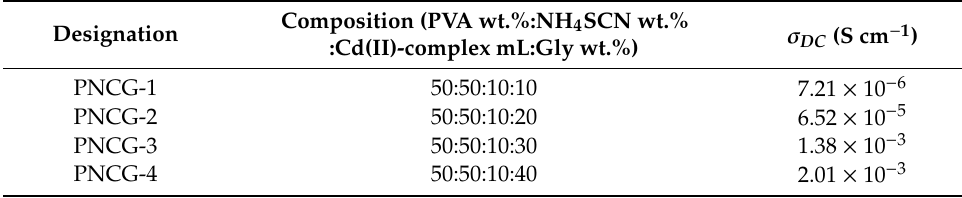
Figure 4. Electrochemical impedance spectroscopy (EIS) plots for ( a ) PNCG-1, ( b ) PNCG-2, ( c ) PNCG-3, and ( d ) PNCG-4 electrolytes. Table 4. Achieved σ DC of the PVA:NH 4 SCN:Cd(II)-complex:Gly system at room